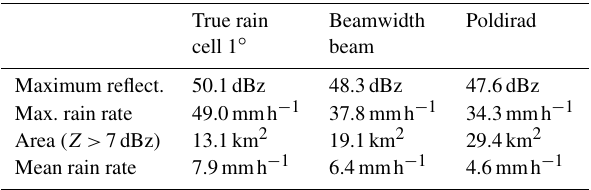
Table A1. Effect of azimuthal beamwidth on a simulated rain cell. True rain Beamwidth Poldirad cell 1 ◦ beam Maximum